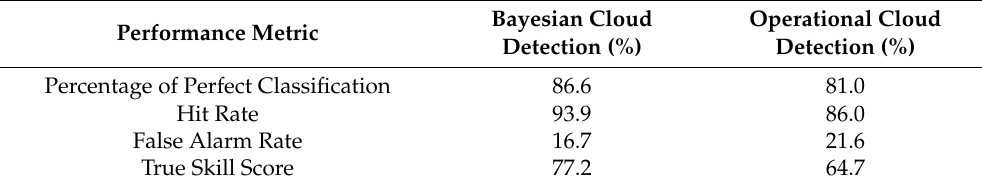
Table 4. Cloud detection performance metrics for Bayesian and operational cloud masks compared to manually masked AATSR data from the SYNERGY and ESA DUE GlobTemperature projects.